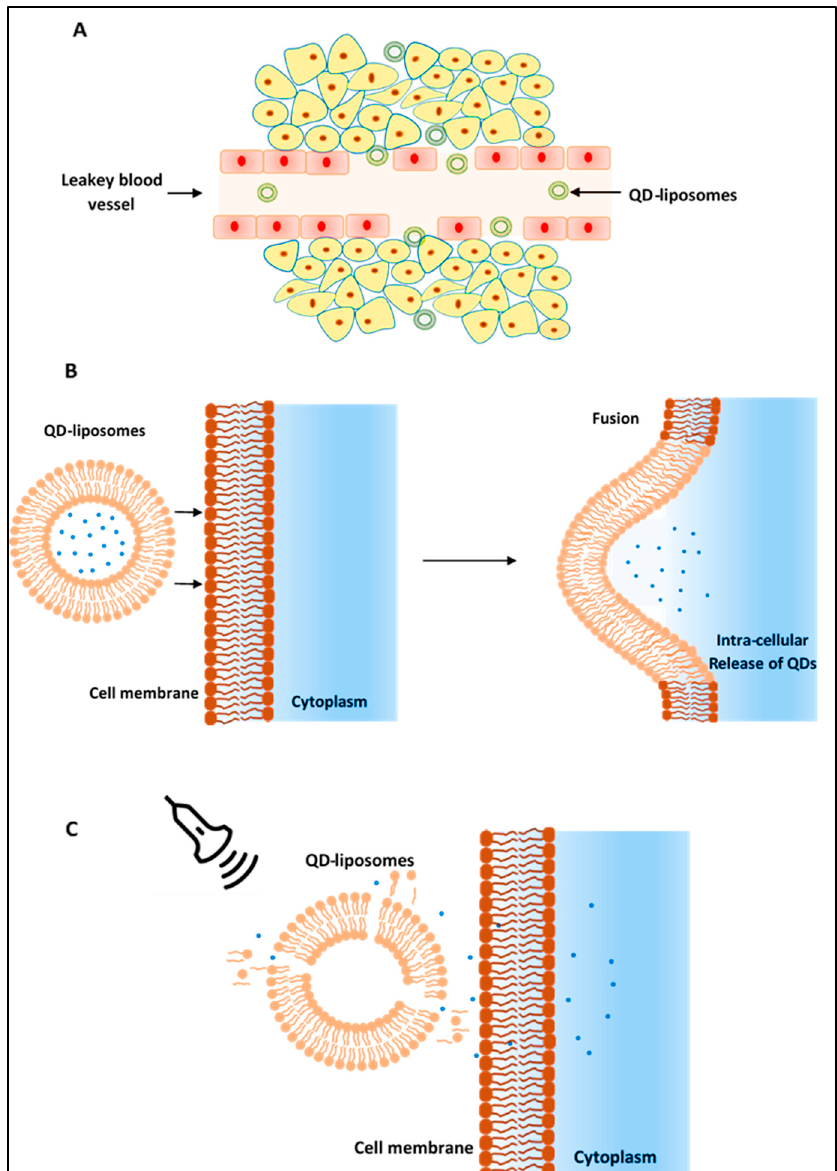
Figure 5. ( A ) QD ‐ liposomes are able to extravasate through the leaky vessels surrounding the cancer cells (EPR effect) allowing their accumulation at the tumor site. ( B ) QD ‐ liposomes are then taken up by the cells through their fusion with cellular membranes. ( C ) Ultrasound can be applied on the tumor site to trigger the release of QDs encapsulated inside the liposome and enhance their uptake by the cancer cells mainly through the sonoporation effect produced by the